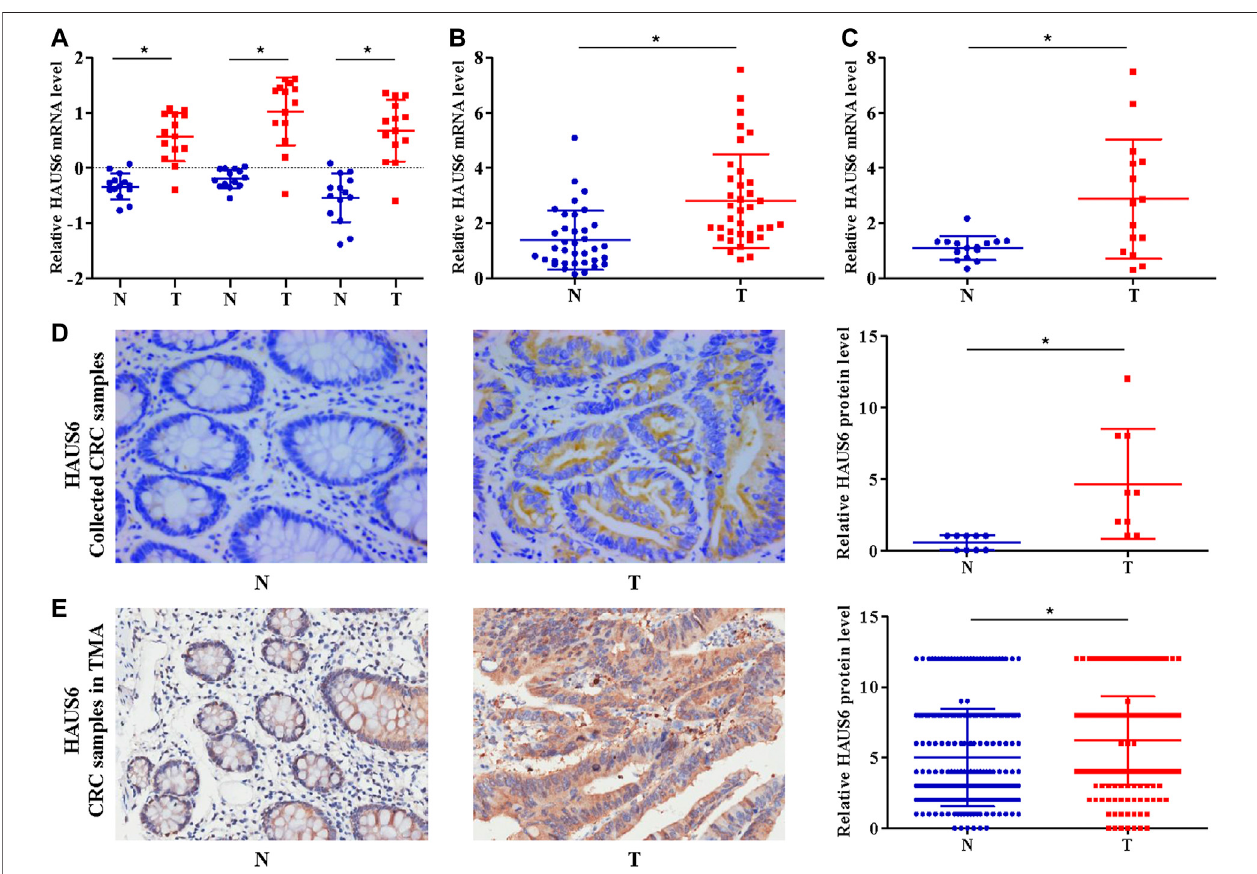
FIGURE 1 | HAUS6 mRNA and protein are up-regulated in CRC tissues. (A) HAUS6 expression (3 different probes) in 14 matched CRC and noncancerous colorectal tissues from our previously described gene expression pro fi le microarrays (GEO Submission: GSE113513). Each dot represents 1 tissue; Mean ± SD; * p < 0.05,vs.N,pairedStudent ’ s t test. (B,C) QuantitativeRT-PCRdetermination ofHAUS6mRNAexpressionin (B) 36matchedCRCandnoncancerouscolorectal tissues collected by our laboratory and (C) 15 matched CRC and noncancerous colorectal tissues from commercially available cDNA arrays. GAPDH was used as an internal control. Mean ± SD; * p < 0.05, vs. N, by paired Student ’ s t test. (D,E) Immunohistochemistry to determine HAUS6 protein levels in (D) 10 matched CRC and noncancerous colorectal tissues collected by our laboratory (Magni fi cation: × 40) and (E) 260 matched CRC and noncancerous colorectal tissues from commercially available tissue microarrays (Magni fi cation: × 20). Representative images are shown on the lower panel. Mean ± SD; * p < 0.05, vs. N, by paired Student ’ s t test. T: colorectal cancer tissues; N: noncancerous colorectal tissues.